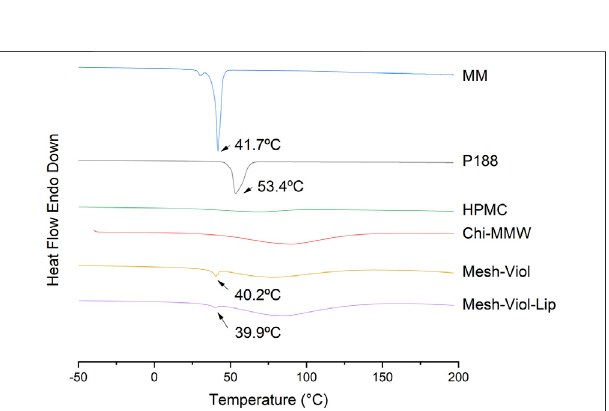
FIGURE 8 | Thermogravimetric analysis for Mesh-Viol-Lip, Mesh-Viol, MM (myristyl myristate), Chi-MMW (medium molecular weight chitosan), HPMC (hydroxypropyl methylcellulose), and P188 (Poloxamer P188). Mesh- Viol andMesh-Viol-Lip wereincubated inphosphate buffer (pH =7.4) for 24 h before performing the analysis.